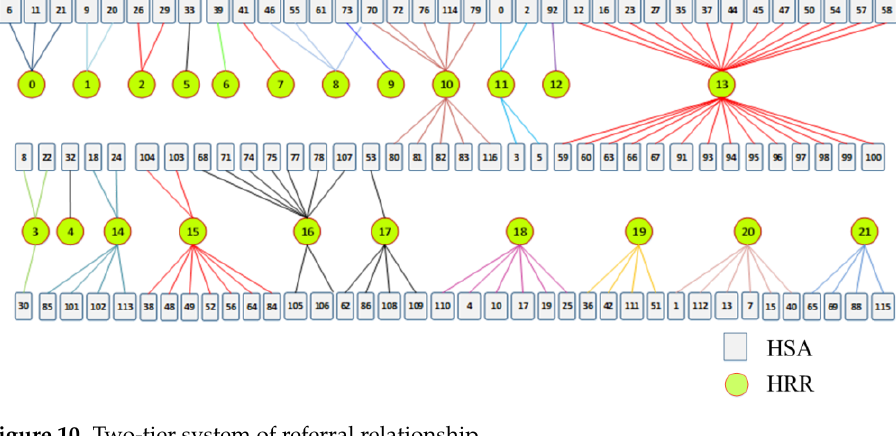
Figure 10. Two-tier system of referral